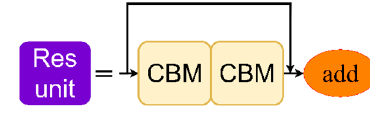
Figure 2. CBL and CBM modules.